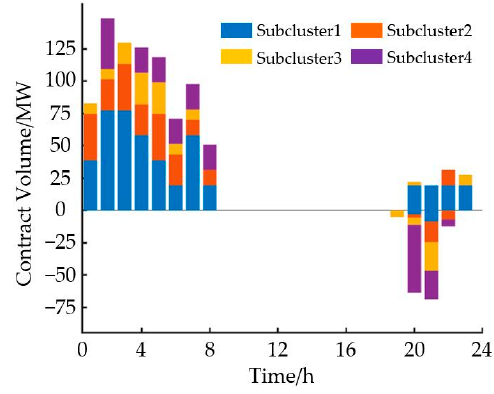
Figure 4. Contract volume reached among all the subclusters of main cluster 3.